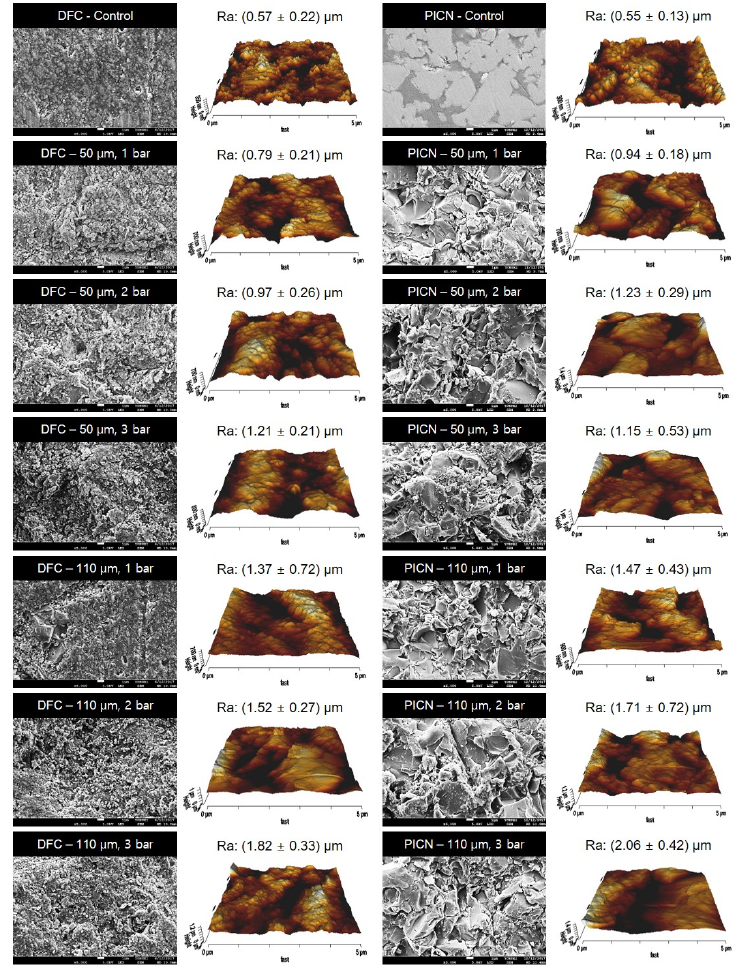
Figure 6. Representative scanning electron microscopy and atomic force microscopy images of different disperse-filled composites (DFC) and polymer-infiltrated ceramic networks (PICN) surface treatment groups. Table 2. Surface roughness of disperse-filled composites (DFC) and polymer-infiltrated ceramic networks (PICN) groups subjected to air abrasion at different pressures with alumina particles of different sizes.